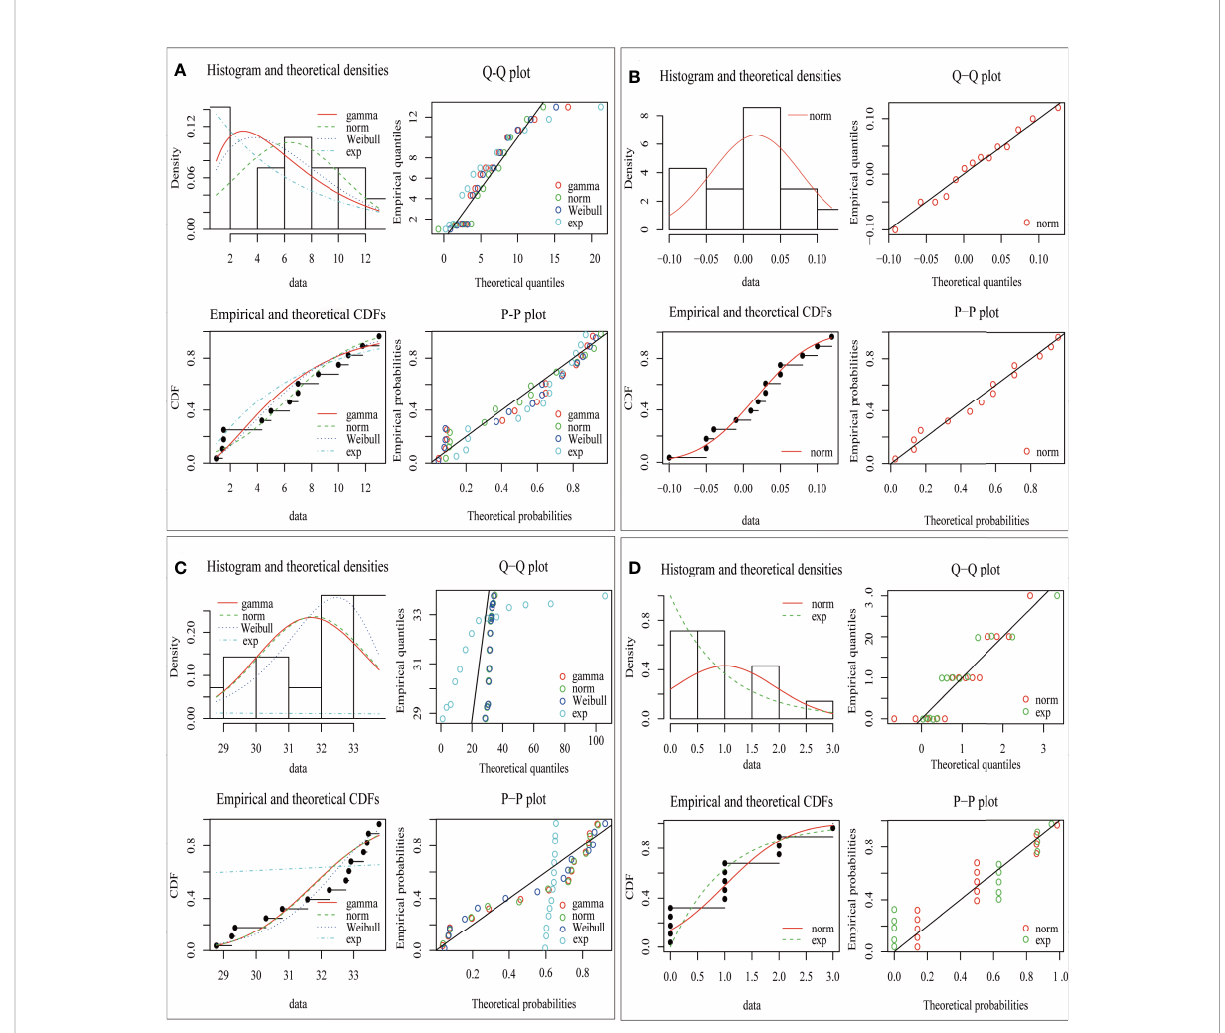
FIGURE 2 Distribution of simulated data of four environmental factors from 2001 to 2014. (A) Red tide area, (B) sea level height, (C) sea surface salinity, and (D) typhoon landing